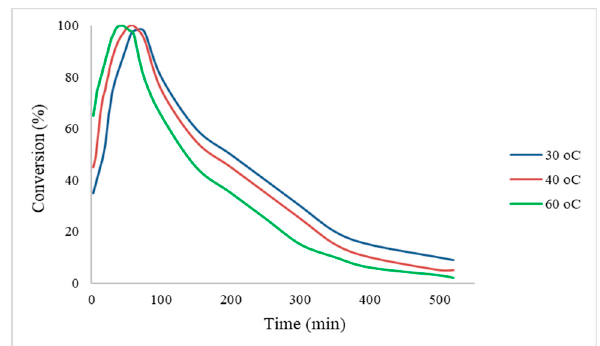
Figure 5. Effect of temperature on the conversion of formic acid. Reaction conditions: pressure = 1 bar; inlet flow = 0.05 mL/min; 0.1 g catalyst of 5 wt.% Pd on Carbon.